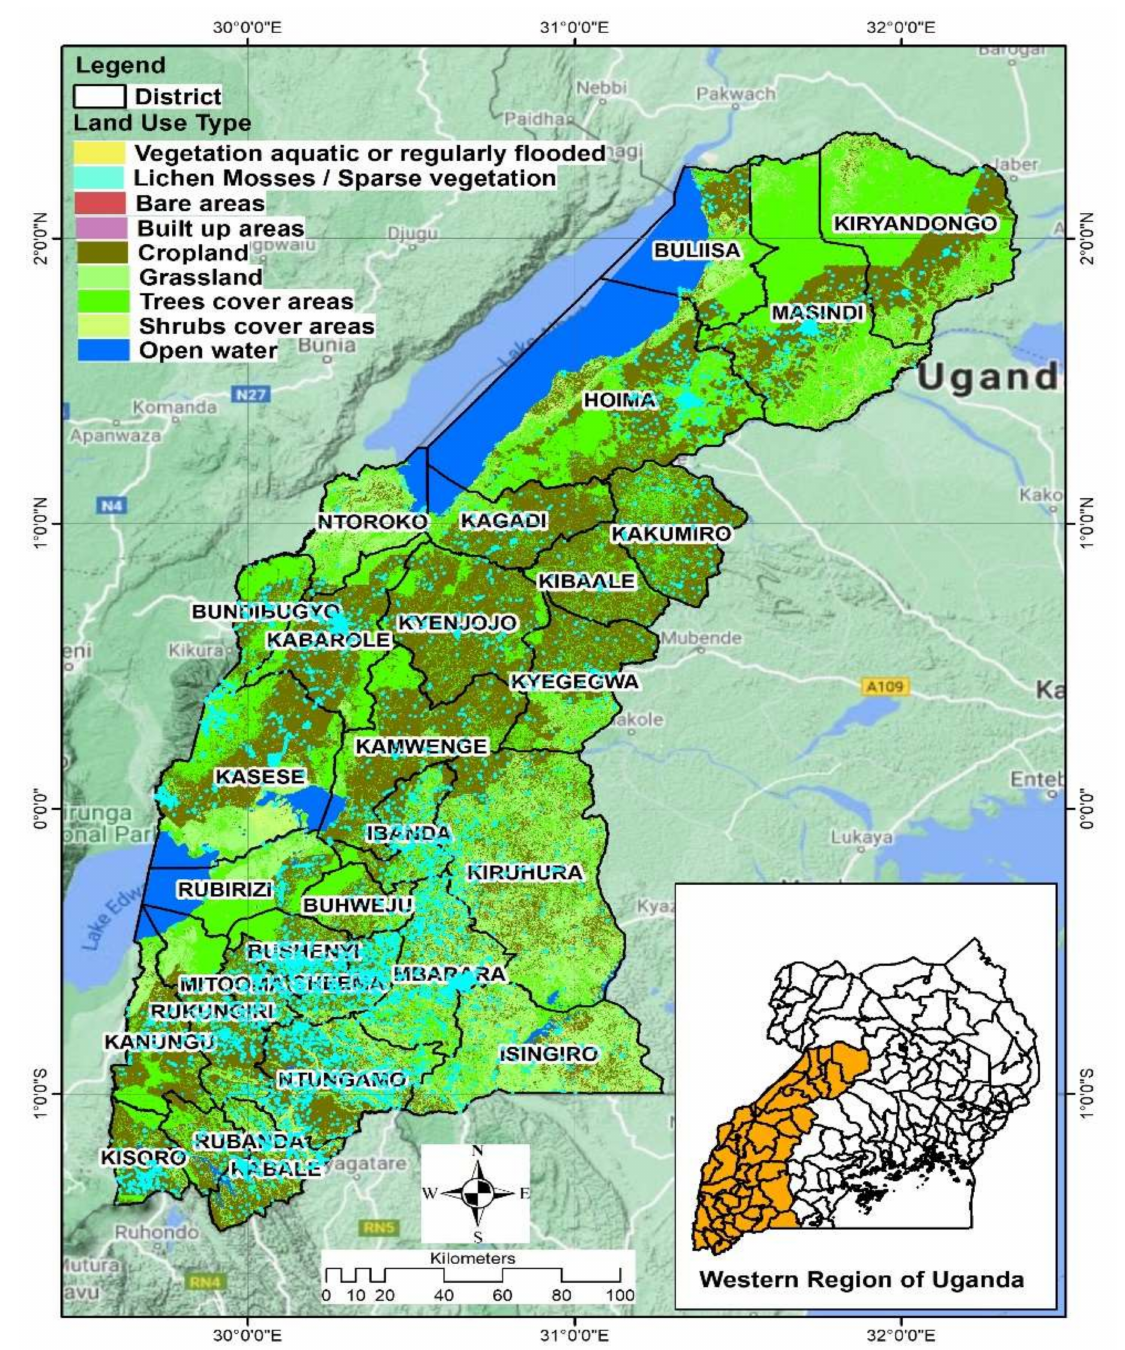
Figure 8. Map of study area land